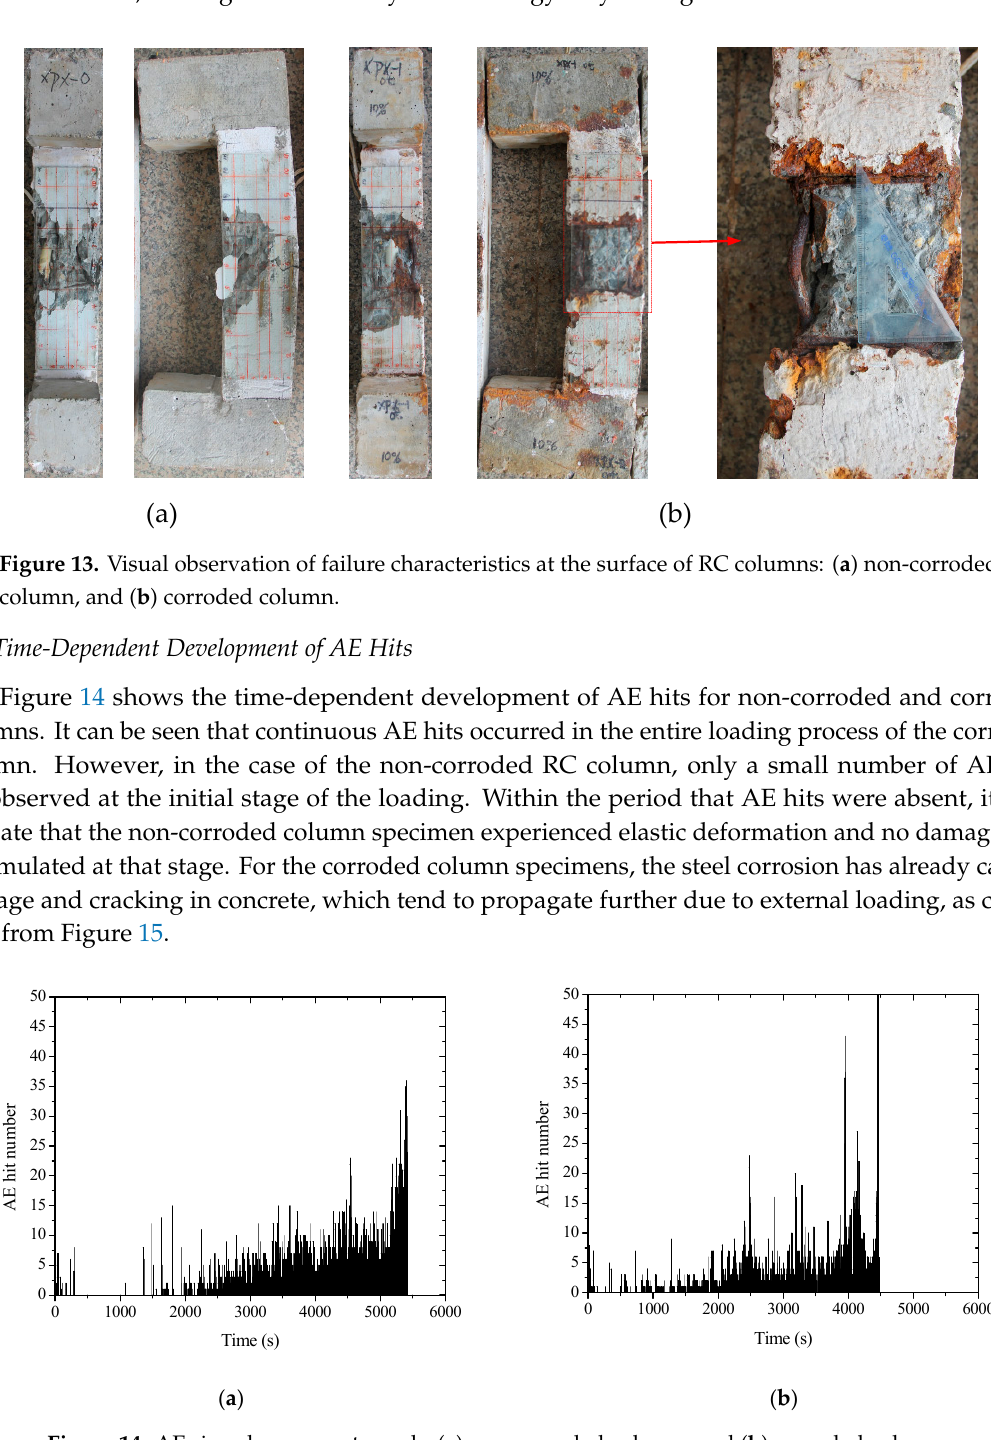
Figure 14. AE ring-down count graph: ( a ) non-corroded column, and ( b ) corroded